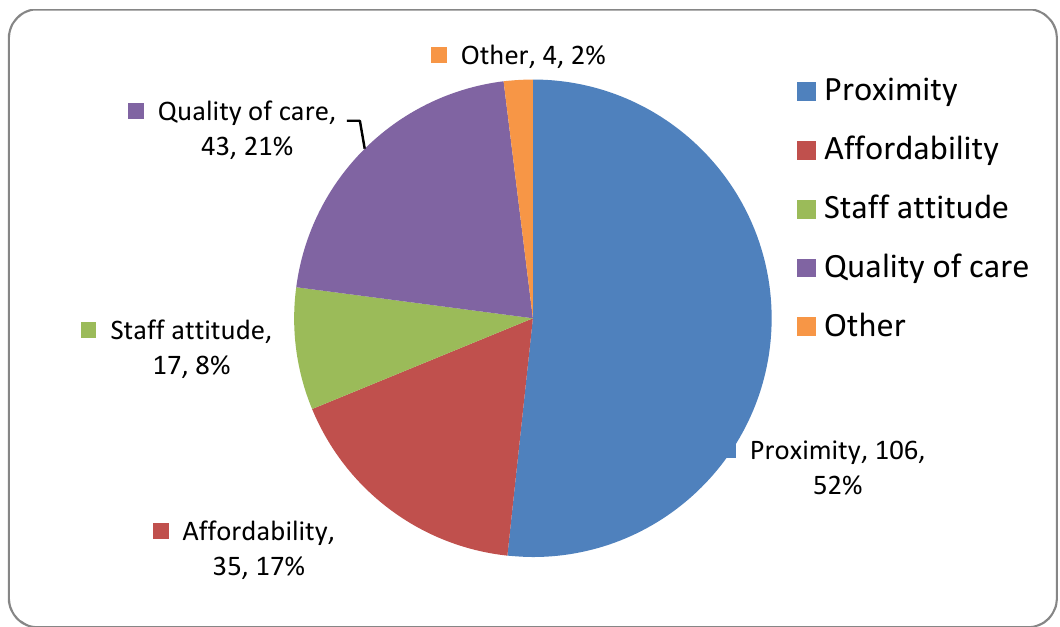
Figure 4. Reasons given by caregivers of outborn neonates for choosing a health facility.